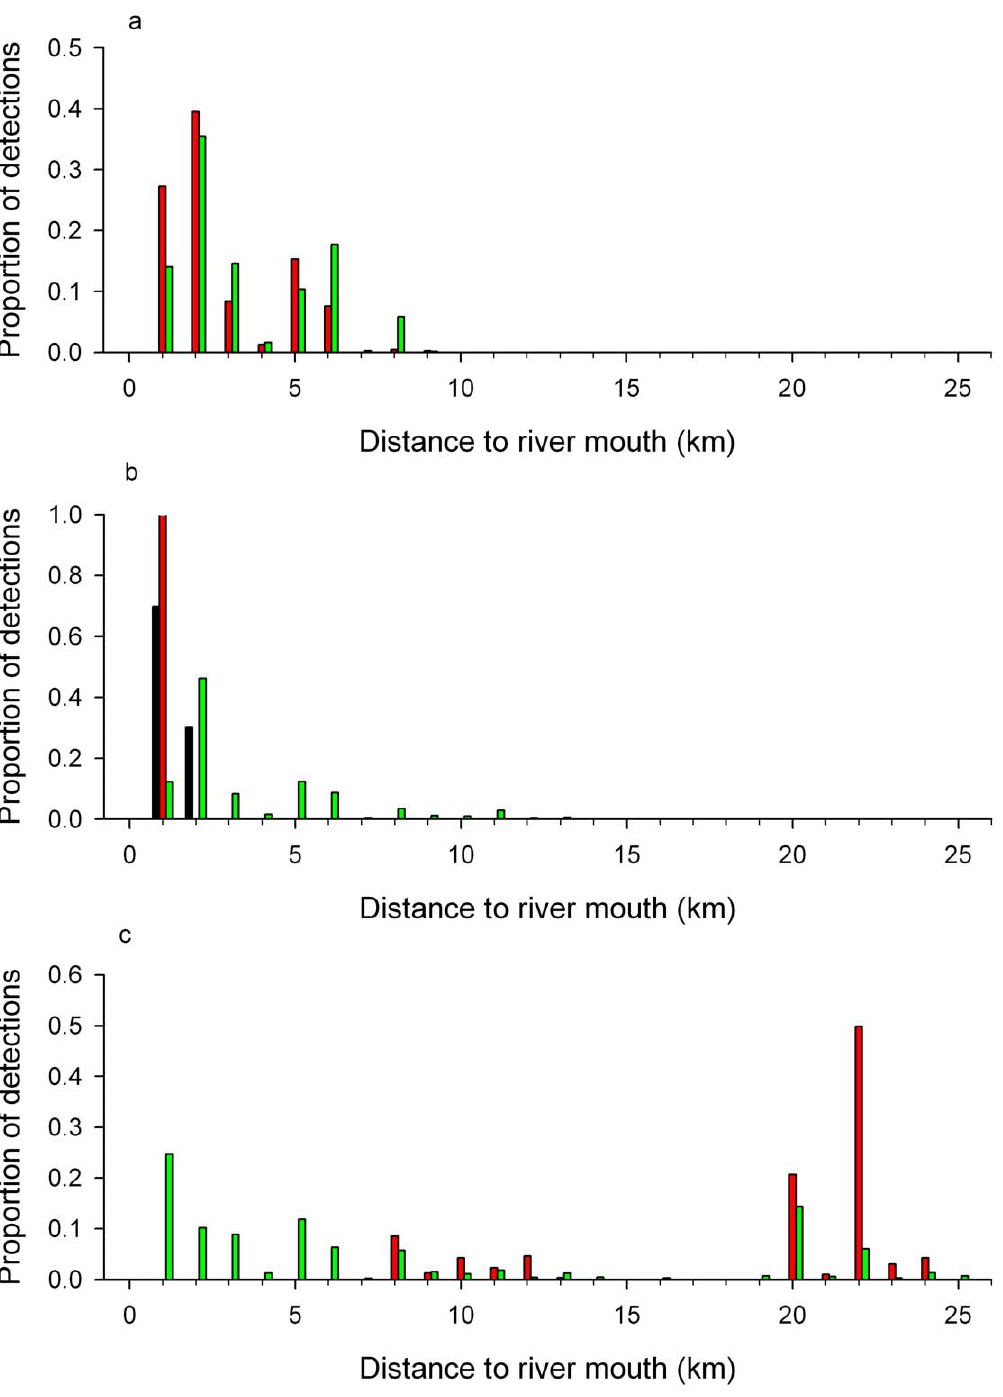
Figure 6. Distribution of neonate (black bars), young-of-the-year (red bars) and . 1 year old (green bars) Pristispectinata within the Caloosahatchee River. (a) 2005, (b) 2006 and (c) 2007 based on detections by acoustic receivers. Location was calculated as kilometers from the river mouth using a linear mean-position algorithm.